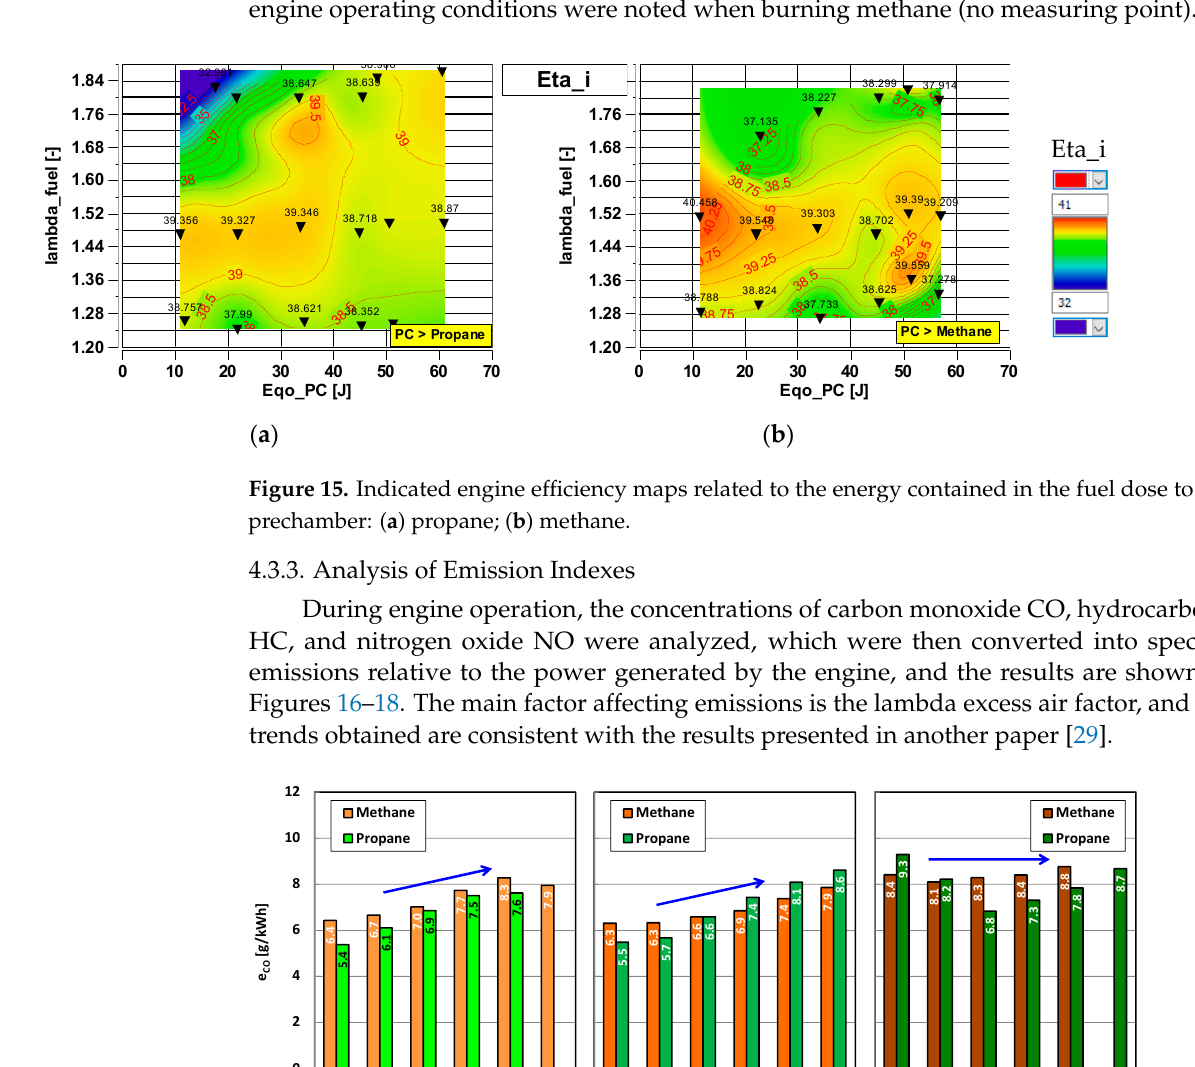
Figure 14. Indicated engine e ffi ciency related to the value of energy supplied to the prechamber during the combustion of methane and propane.